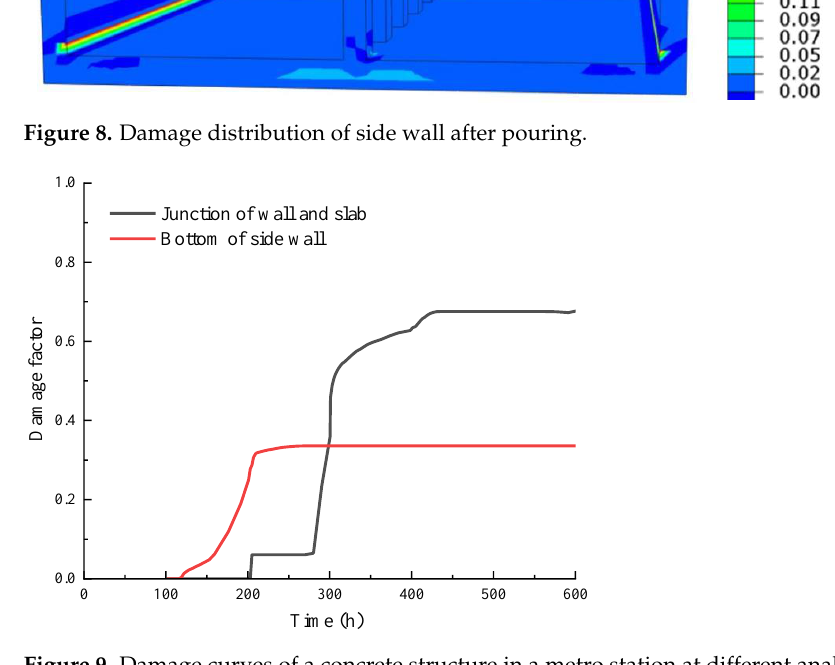
Figure 9. Damage curves of a concrete structure in a metro station at different analysis points.